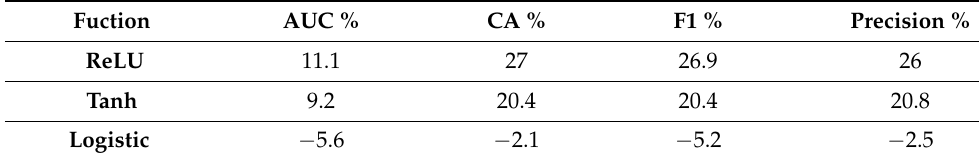
Table 7. The percentage of classification